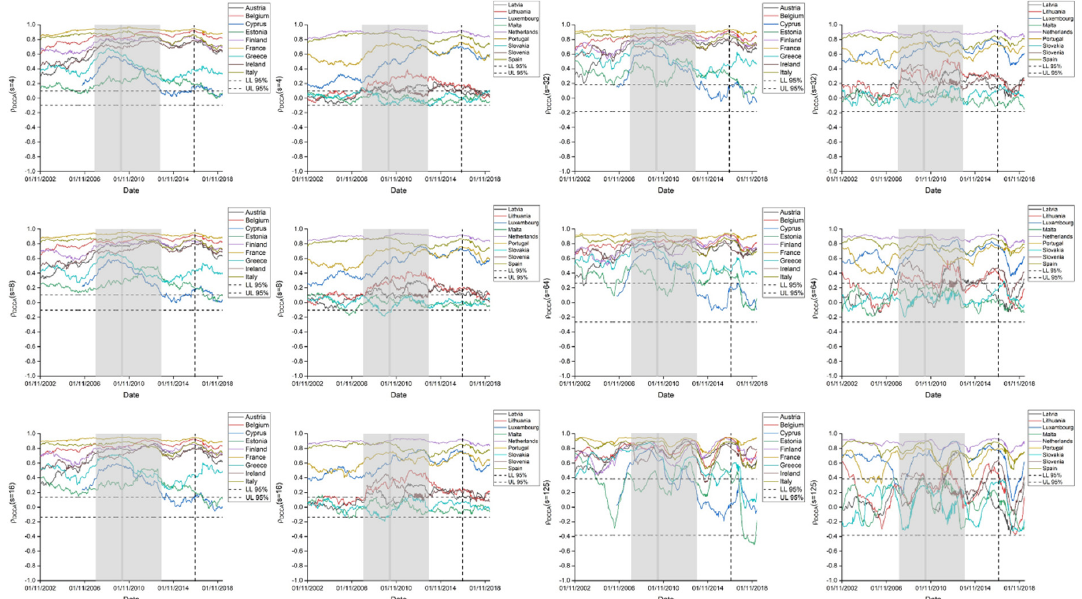
Figure A3. Evolution of ρ DCCA between Eurozone stock markets and Germany (time scales of 4, 8, 16, 32, 64, 125, and 250 days with a window size w = 500). LL and UL are, respectively, the lower and upper limits of the confidence interval. Shaded areas represent the global financial crisis and the Eurozone debt crisis. The vertical dashed line refers to the moment of the Brexit referendum.